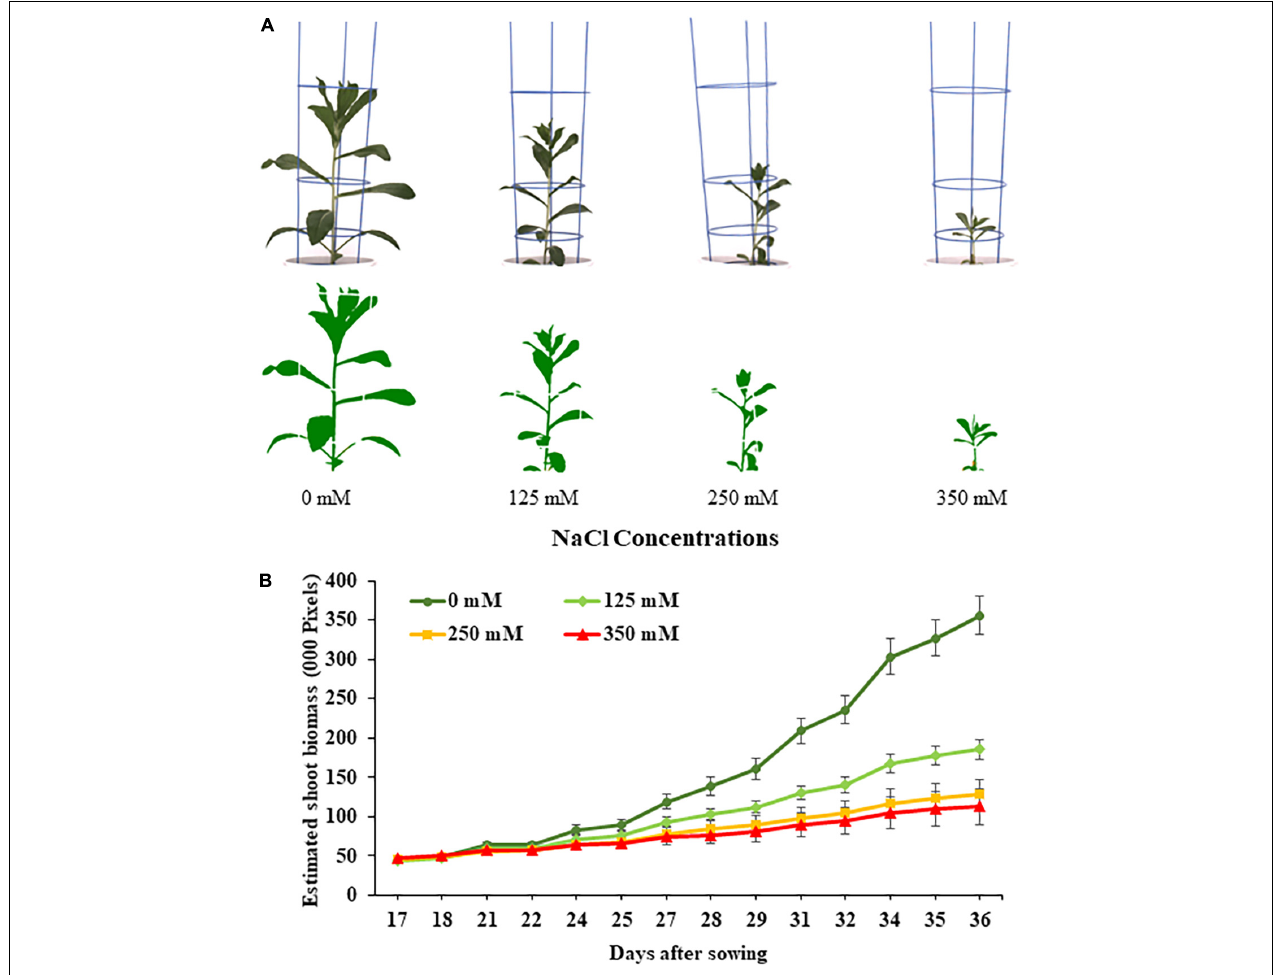
FIGURE 1 | Performance of safflower genotypes under four salt (NaCl) concentrations from first experiment. (A) Raw and processed images of representative safflower plants at 36 days after sowing from the four salt treatments. (B) Growth curves showing the average performance, as estimated shoot biomass, of safflower genotypes across the growing period under four salt treatments. Data shown as mean with standard deviation. n =